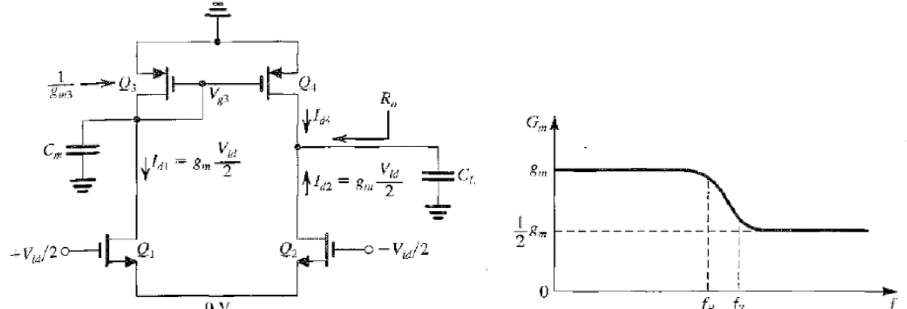
Fig. 10 Differential ampli- fier circuit equivalent and Frequency response of active- loaded differential